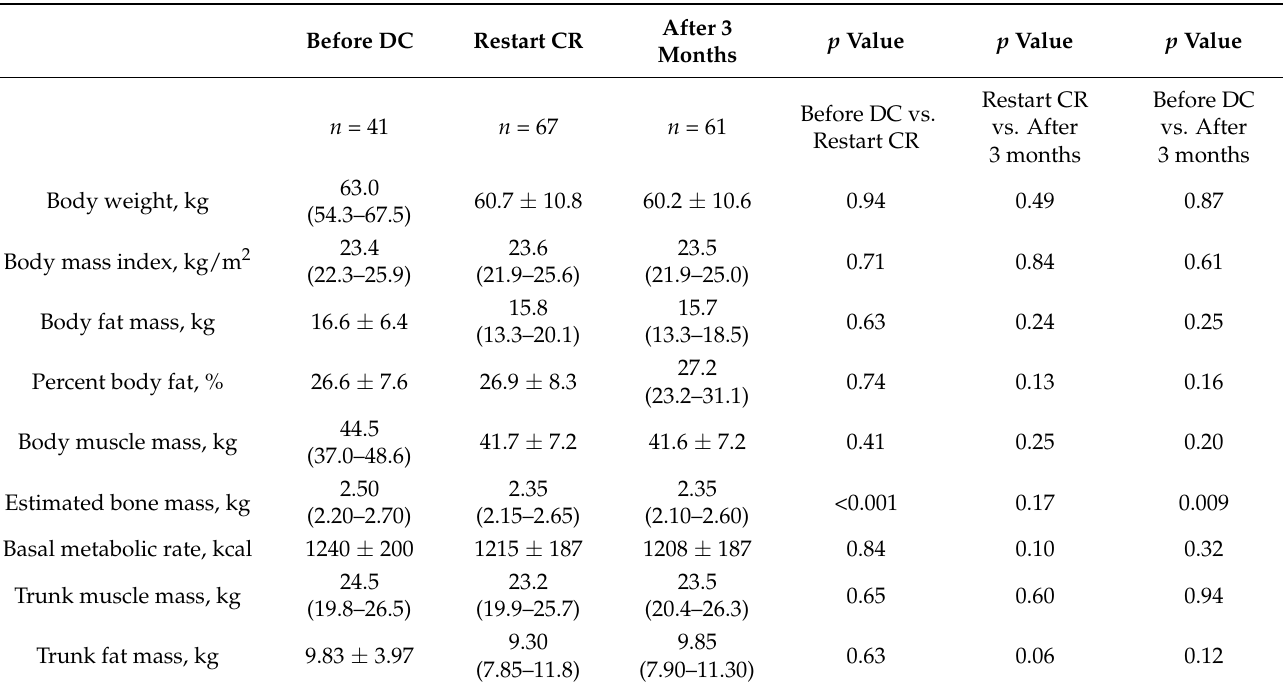
Table 3. Changes in body composition, before DC, at restart of CR and after 3 months.